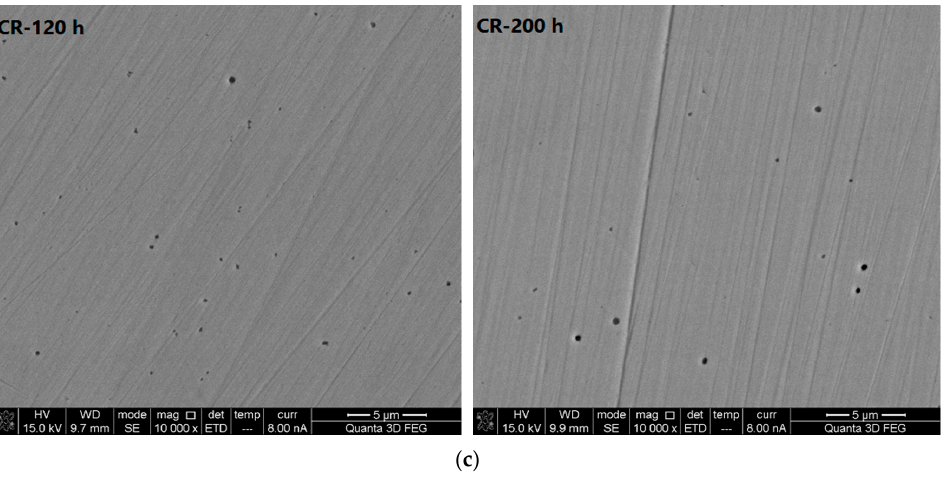
Figure 7. Scanning electron microscope photos (10,000× magnification) of corrosion-resistant alloy steel bars at different corrosive exposure times. ( a ) Micrograph of CR at 0 and 24 h; ( b ) Micrograph of CR at 60 and 100 h; and ( c ) Micrograph of CR at 120 and 200 h.